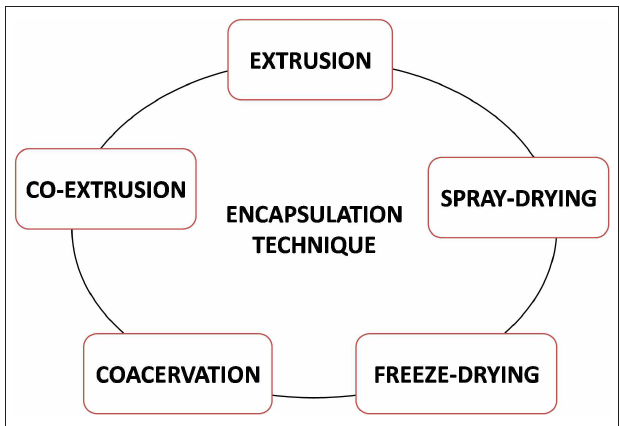
FIGURE 3 | Different techniques for EO